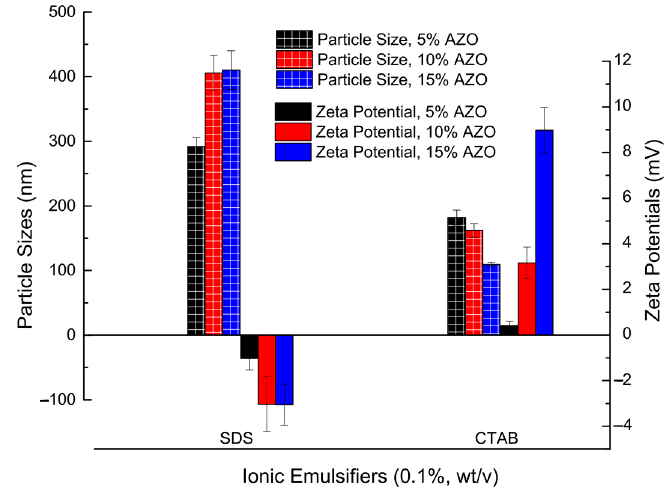
Figure 5. Particle sizes and zeta potentials of AZO-loaded NPs prepared with ionic emulsifiers.